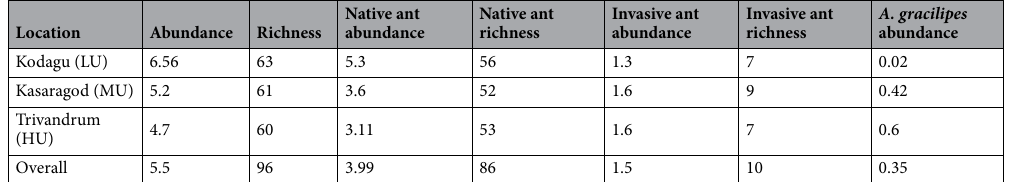
Table 1. Summary of ants sampled in three locations representing the levels of urbanization (LU = less- urbanized; MU = moderately-urbanized; HU = highly-urbanized). The percent share of native and invasive ants is given. The percent share of A. gracilipes is on the total abundance of